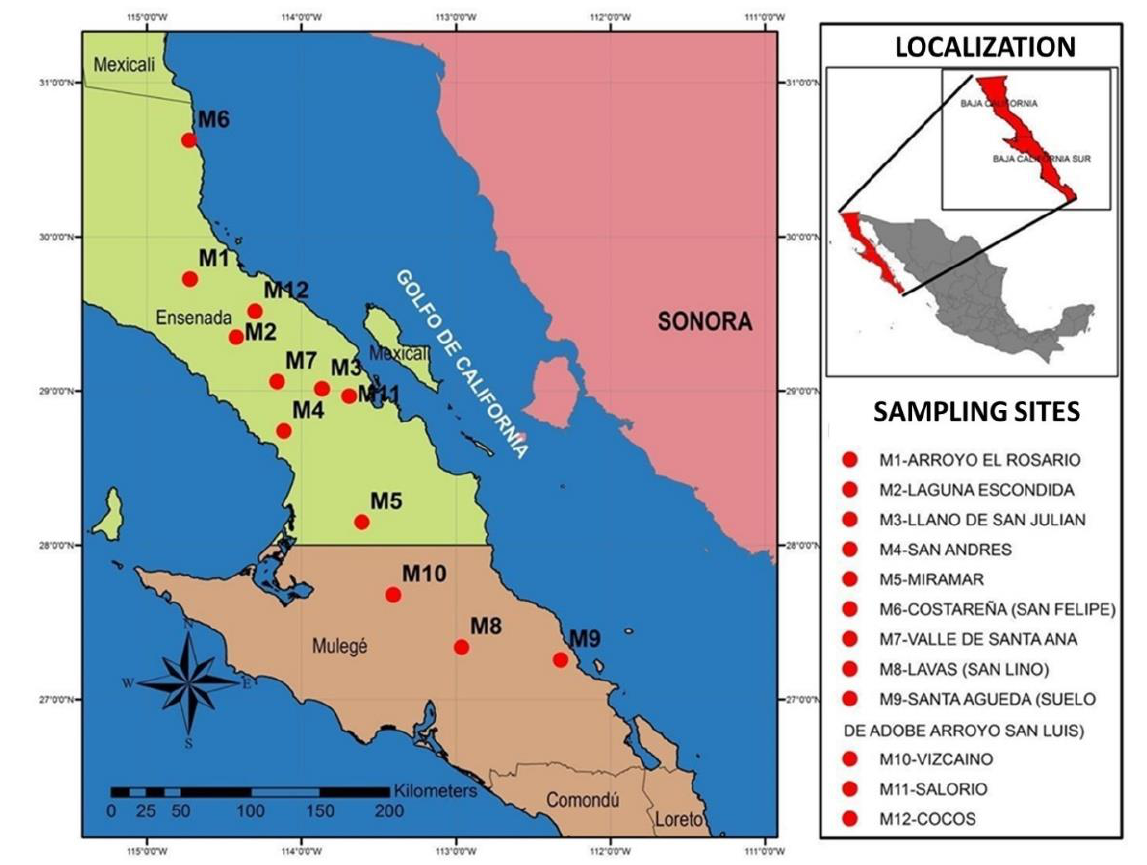
Figure 1. Localization of sampling sites.